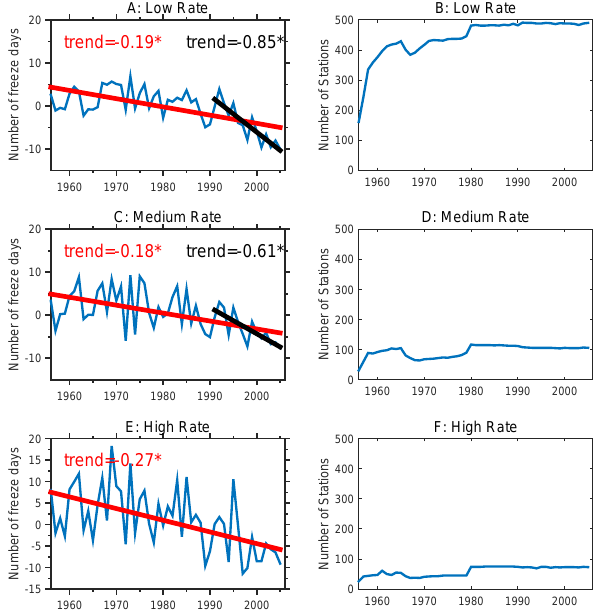
Figure 11. Regional changes of number of days (NF) in regions with different urbanization rates (left panels, i.e., a , c , and e ). Black lines and red lines depict the linear regression for the period after 1990 and the period since 1956, respectively. Asterisk indicates a statistically significant trend at a 95% confidential level or higher. Right panels ( b , d , and f ) are the number of stations used to create each time